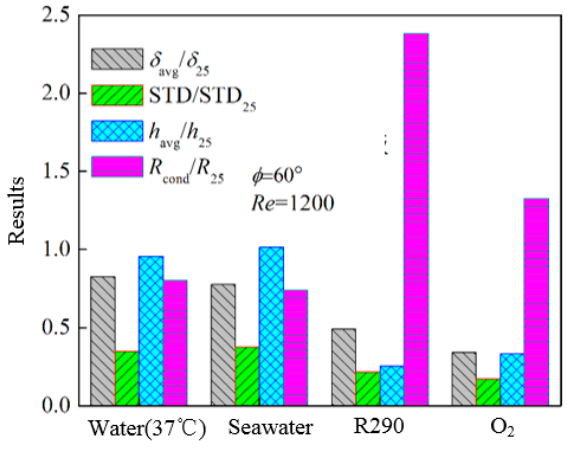
Figure 10. Dimensionless results on the triangular corrugated plate.